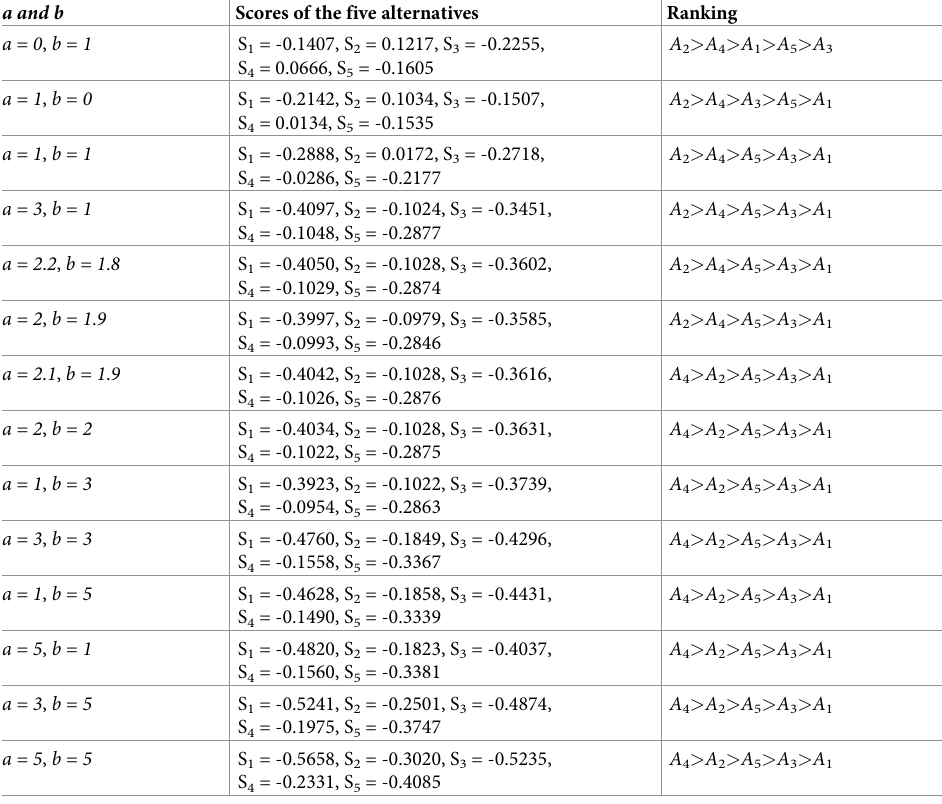
Table 8. The results of experiment